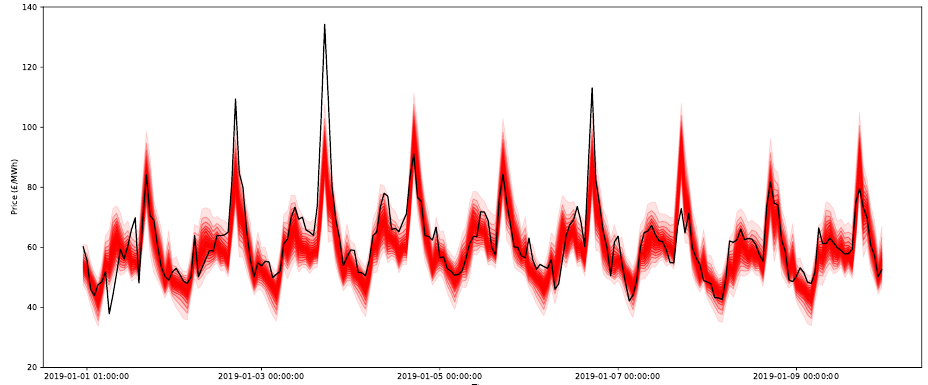
Figure 17. Sample of the ARX model’s forecast for the first nine days of the test period. The different confidence bounds are given different shades, with the darkest representing the prediction interval for the middle ten percent. The actual prices are given by the black line.